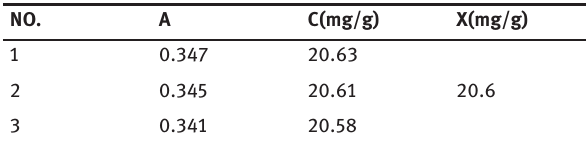
Table 5: The content of total flavonoids in Carthamus tinctorius.